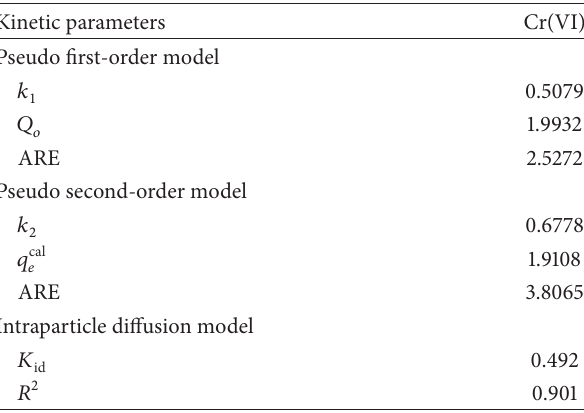
Table 4: Parameters of kinetic modeling for adsorption of phenol. Kinetic parameters Cr(VI)